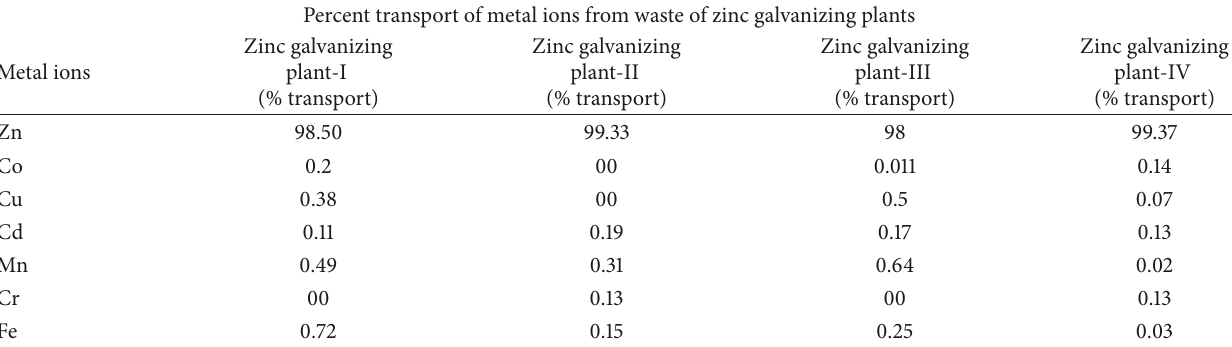
Table 2: Percent transport of metal ions from galvanizing plants